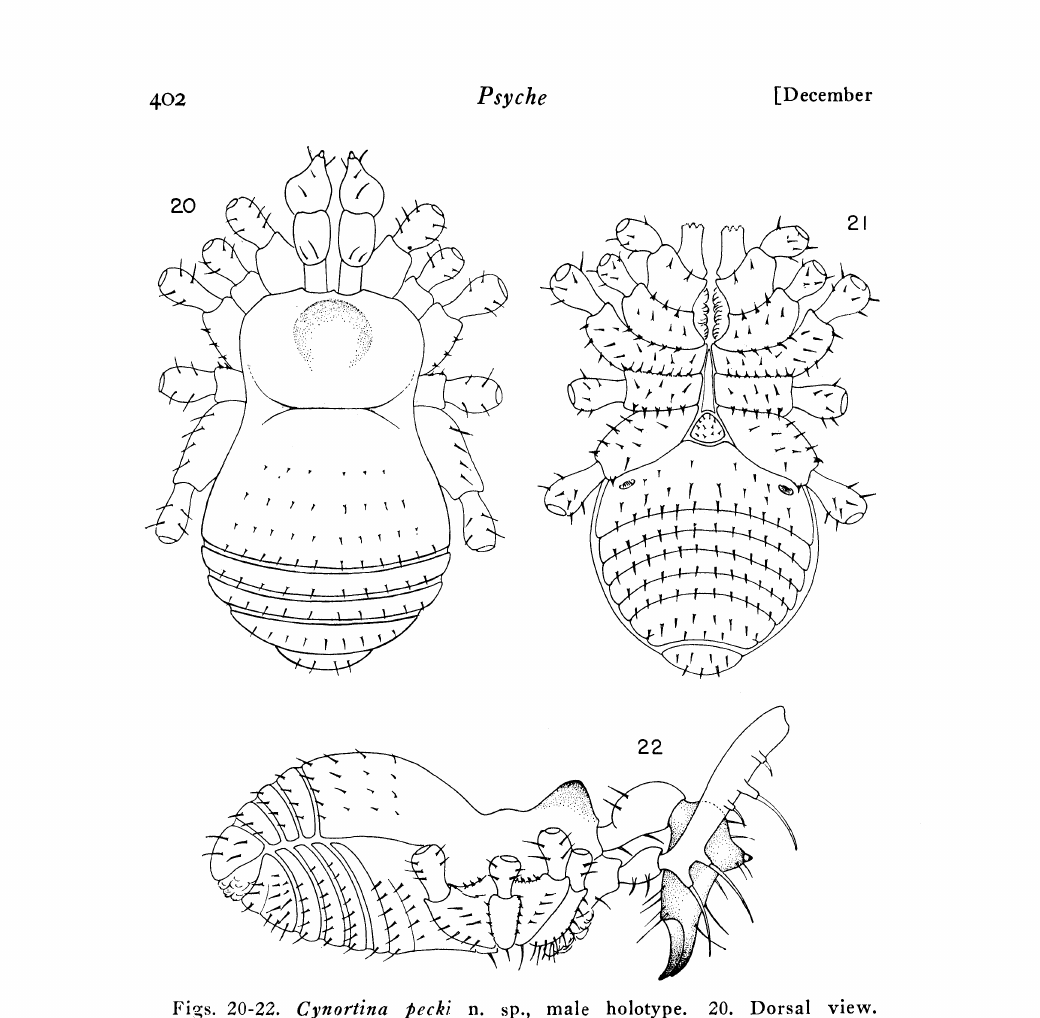
Figs. 20-22. Cynortina ecki n. sp., male holotype. 20. Dorsal view. 21. Ventral view. 22. Lateral view. o.7 ram. Palpal femur, o.7t mm; patella, o.40 mm; tibia, o.54 mm; tarsus, o.46 mm; total length, 2. mm. Femur of first leg, t.35 ram; total length, 5.oo mm. Second femur, 3.32 mm; total length, 9.4 mm. Third femur, .78 ram; total length, 6..7 mm. Fourth femur, 2.7 mm; total length, 8.53